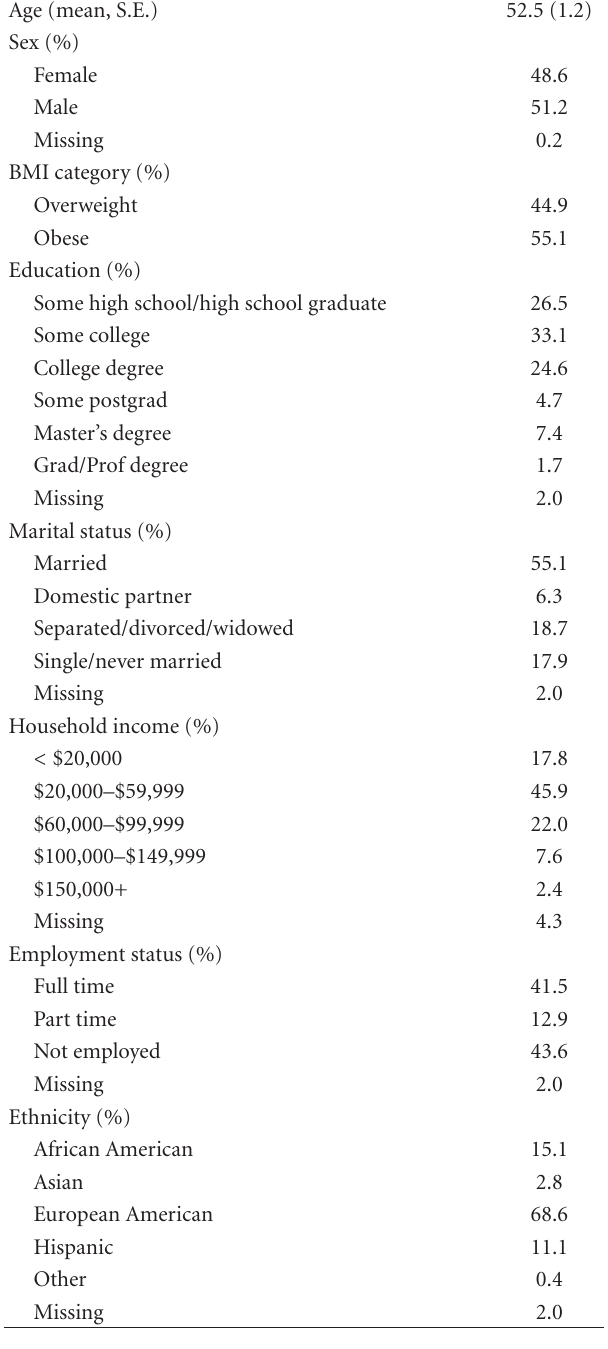
Table 1: Baseline demographics of obese and overweight partici- pants ( N =